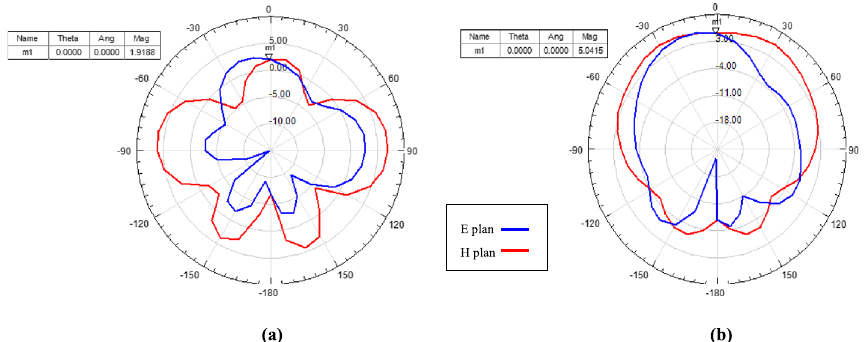
Fig. 12 Simulated antenna radiation pattern at 63.6 THz. a Conventional antenna. b Antenna-based DCB-SRR